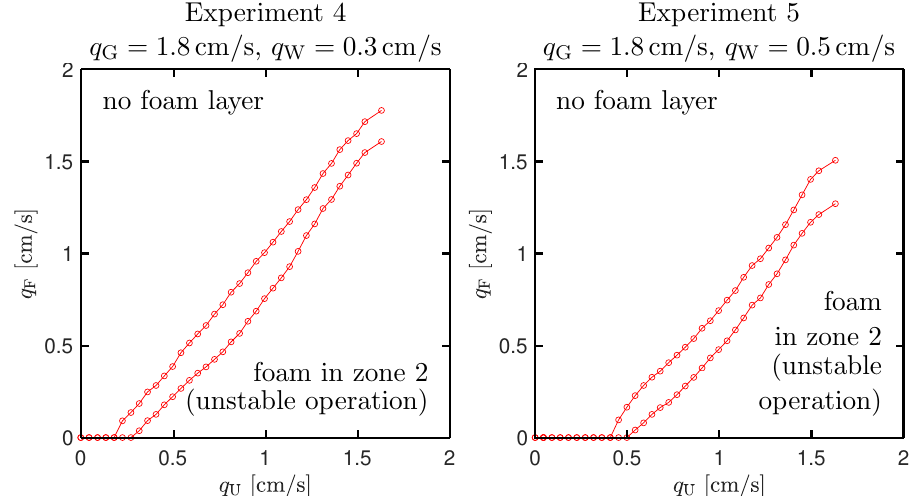
Figure 4. Experiments 4 and 5 (with wash water added): stability regions enclosed between two curves formed by points in the ( q U , q F )